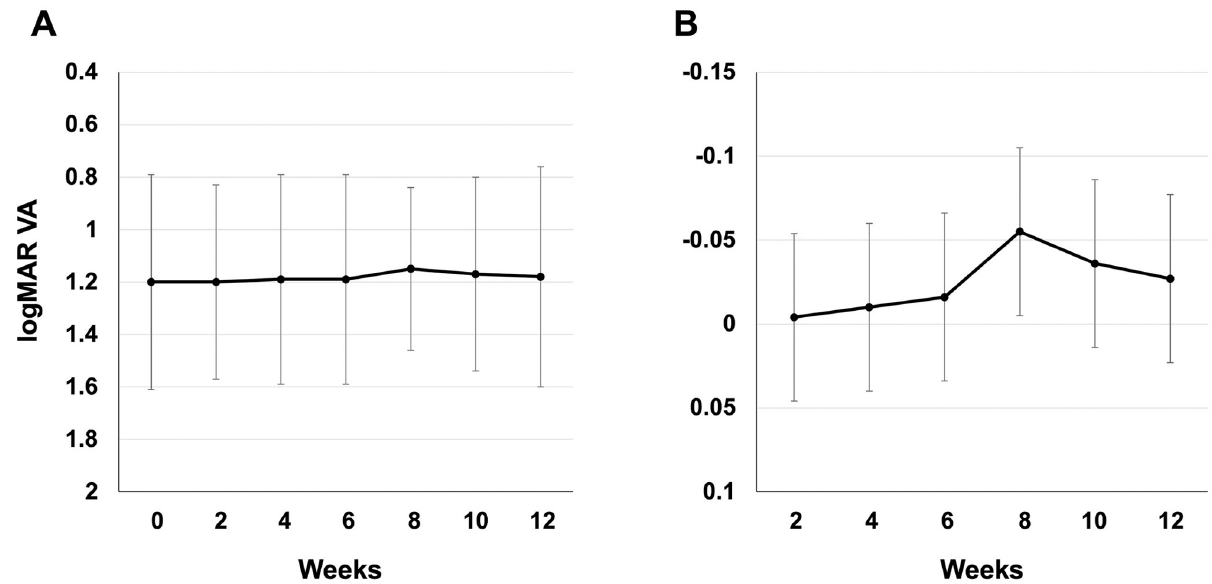
Fig 3. Mean and changes in logMAR visual acuity during the study period. (A) Mean logMAR visual acuity. Whiskers indicate standard deviation. (B) Changes in logMAR visual acuity. Whiskers indicate standard error.